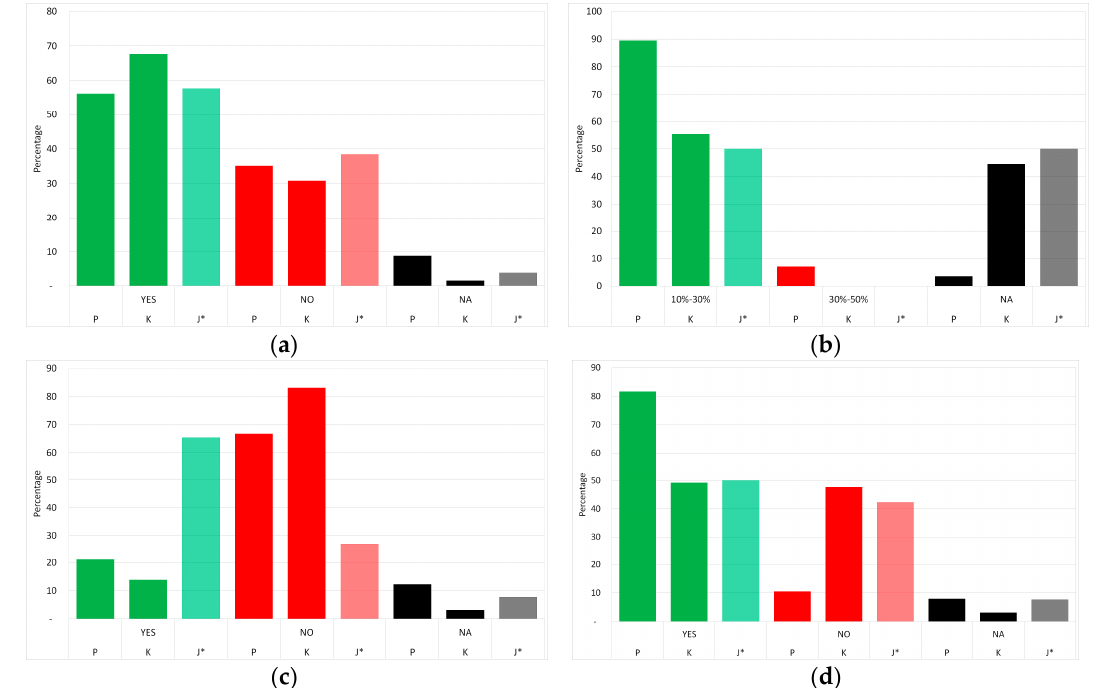
Figure 5. The proportion of respondents’ answers to survey questions in percentages: ( a ) Would you accept an increase in your electricity bill for better electricity service? ( b ) How much increase in your electricity bill would you find acceptable? ( c ) Do you have a backup generator at home? ( d ) Do you experience stable electricity voltage at home? P: Pekanbaru, K: Kupang, J: Jayapura *, NA: No answer.